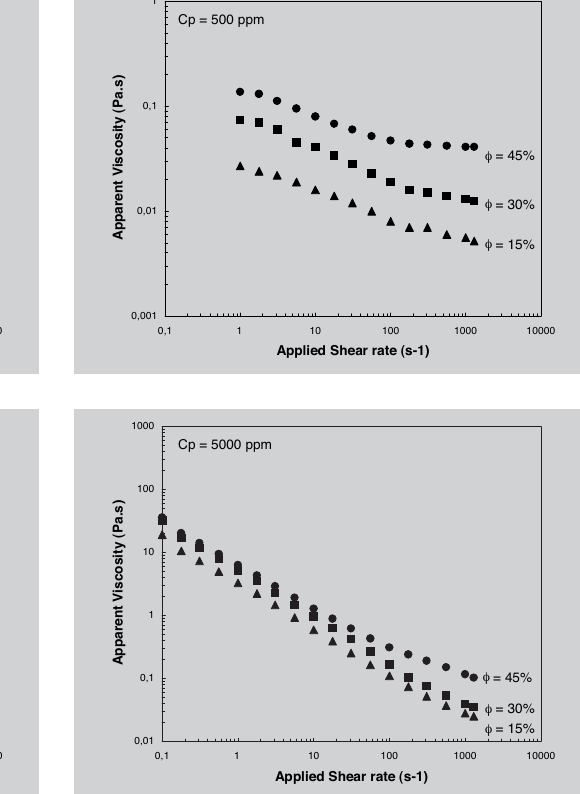
Figure 4 (left above): Apparent viscosity as a function of shear rate for suspensions containing 0 ppm Xanthan, at different solid volume fractions. Figure 5 (right above): Apparent viscosity as a function of shear rate for suspensions containing 500 ppm Xanthan, at differ- ent solid volume fractions. Figure 6 (left below): Apparent viscosity as a function of shear rate for suspensions containing 1200 ppm Xanthan, at different solid volume fractions. Figure 7 (right below): Apparent viscosity as a function of shear rate for suspensions containing 5000 ppm Xanthan, at different solid volume